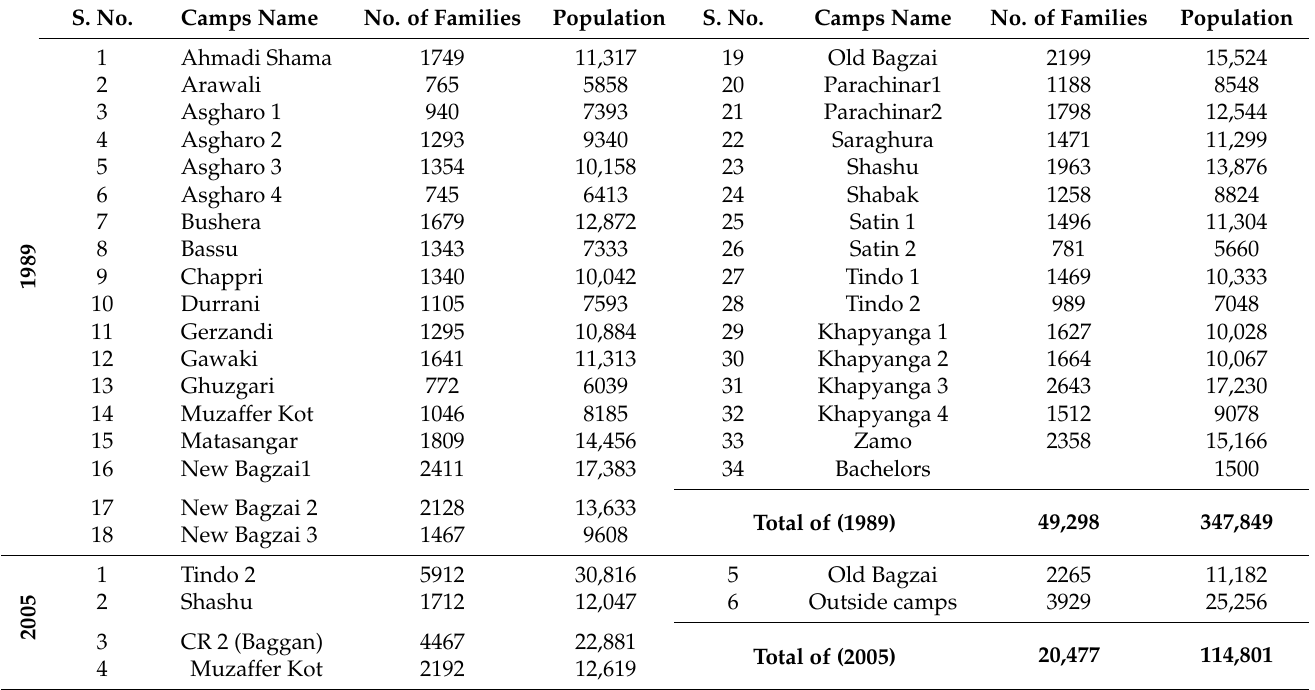
Table 4. Afghan refugee camps with families and population in District Kurram in 1989 and 2005.